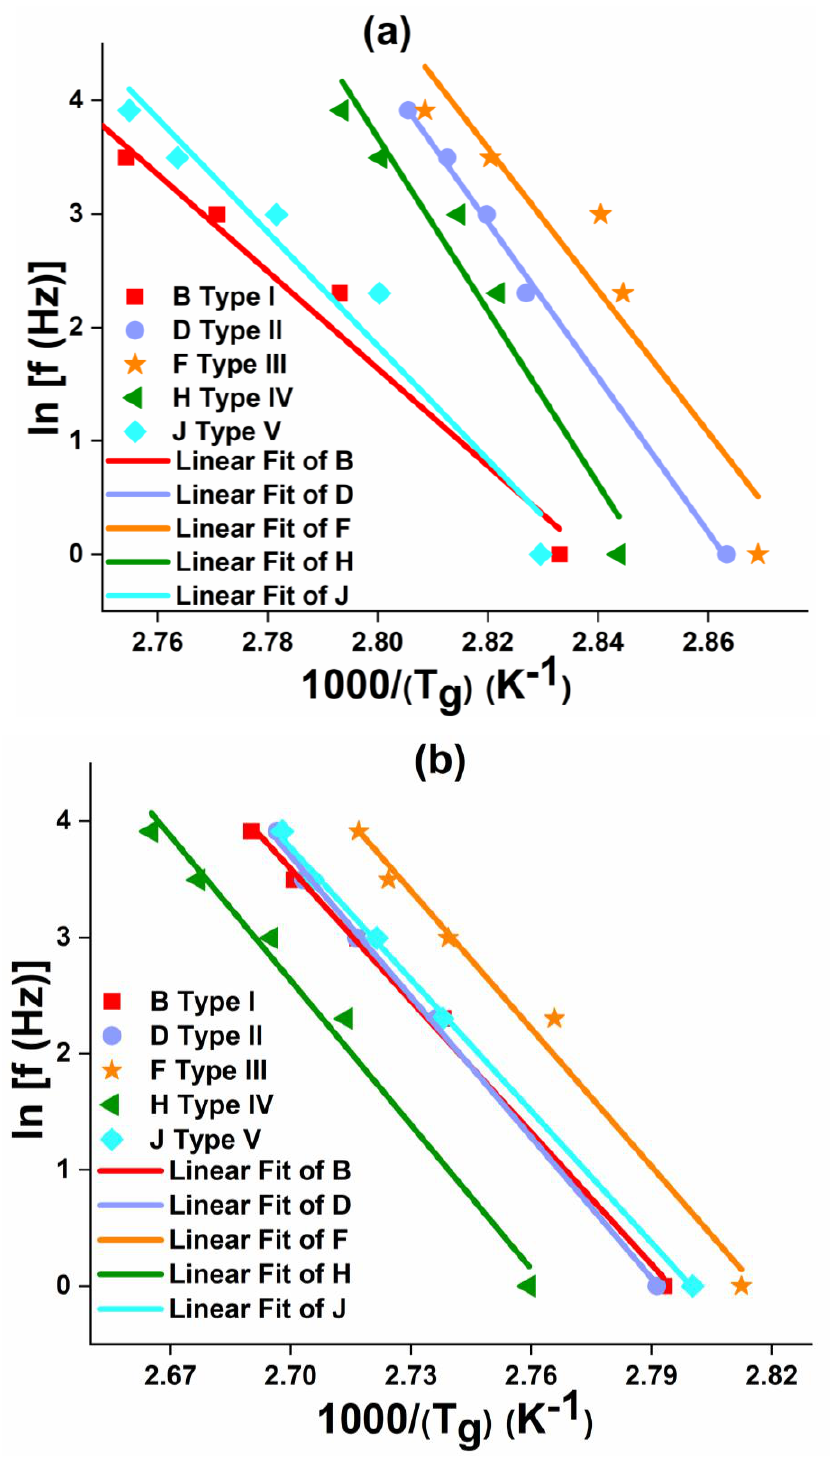
Figure 17. Effect of frequency on T g of GFRP composites: ( a ) loss modulus and ( b ) Loss tangent. Figure 17. E ff ect of frequency on T g of GFRP composites: ( a ) loss modulus and ( b ) Loss